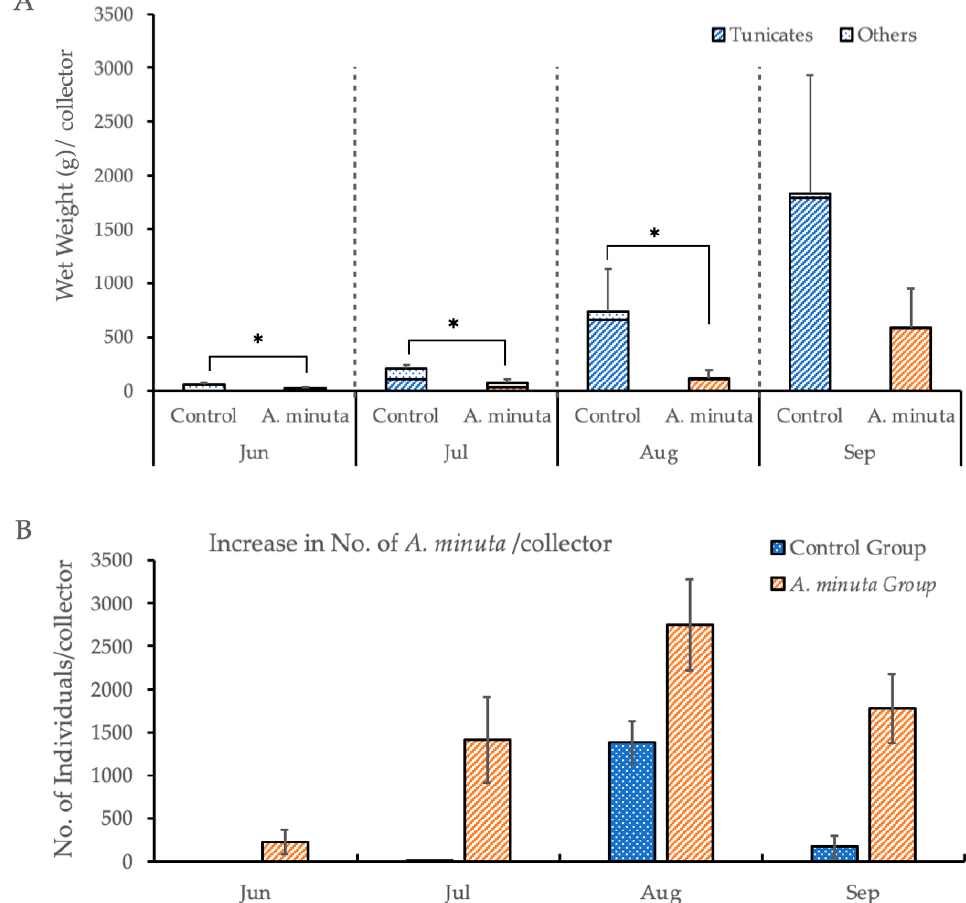
Figure 4. Composition of biofoulers on the collectors in each monthly sampling during the oyster culture period. ( A ) Wet weight of biofoulers attached to collectors submerged at the survey site. Diagonal striped boxes indicate tunicates; dotted boxes, others. ( B ) Population growth of A. minuta on each collector between the control and A. minuta groups. Data are expressed as the mean ± SD (n = 4). Values with an asterisk “*” are significantly different ( p < 0.05).